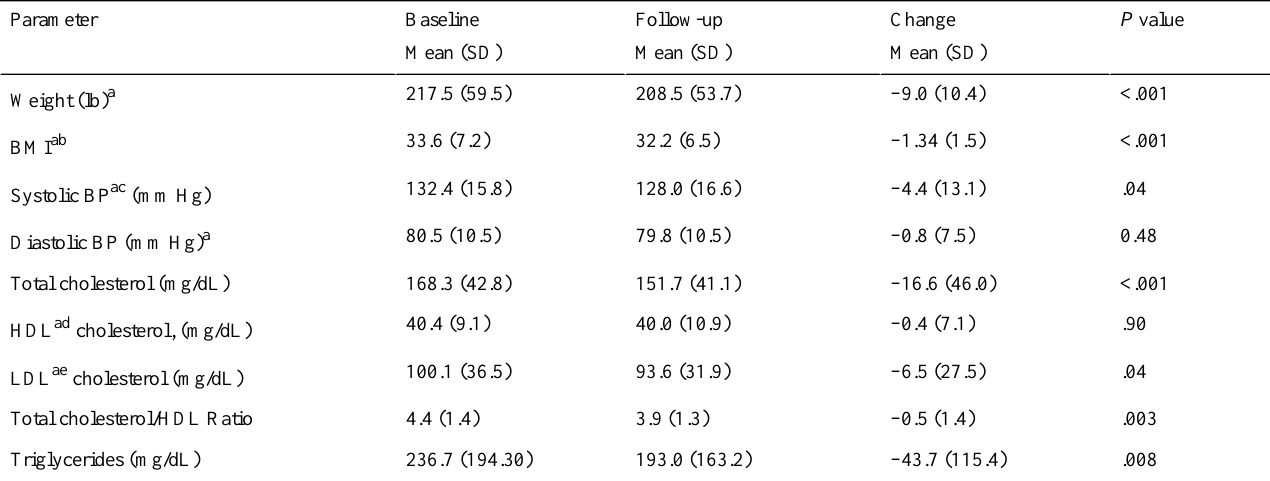
Table 3. Change in BP and serum lipids at 4 months from baseline.